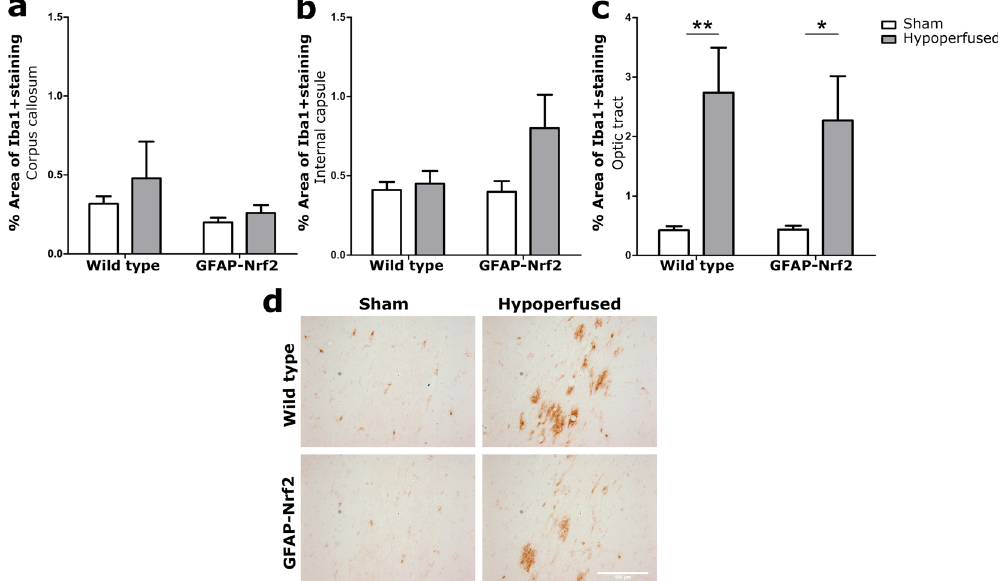
Figure 4. Increased microglia/macrophages in response to hypoperfusion. ( a ) % Area of Iba1 + staining in the corpus callosum and ( b ) internal capsule was unchanged following cerebral hypoperfusion. ( c ) % Area of Iba1 + staining in the optic tract was significantly altered by cerebral hypoperfusion (F (1,32) = 14.74, p = 0.001), with no effect of genotype. ( d ) Representative images of Iba1 + staining in the optic tract. Scale bar 100 µ m. Mean ± SEM. Two-way ANOVA with Bonferroni adjustment for post hoc analysis. * p < 0.05, ** p < 0.01. n = 8–10 per group.